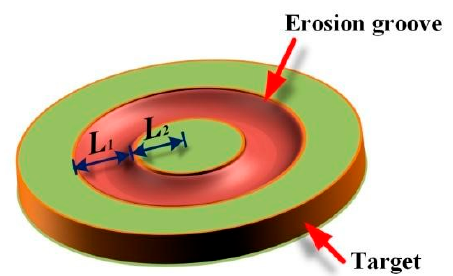
Figure 1. Sketch of the erosion groove on the circular planar target ( L 1 = 15 mm, and L 2 = 5